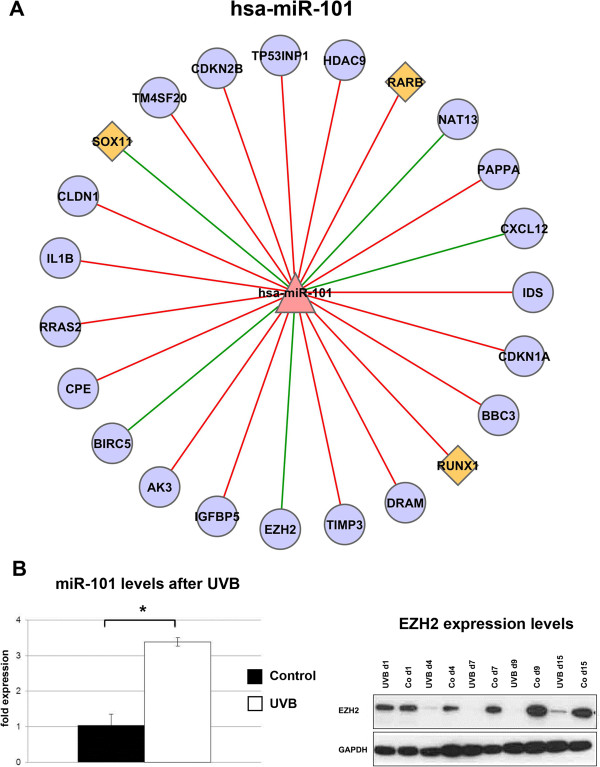
Correlation network of miR-101 and its high confidence target genes. (A) We used 10 prediction tools to obtain, based on public data, candidate miRNA-mRNA target interactions and we identified high confidence targets by mRNA and miRNA expression. We calculated Pearson correlation coefficients between miRNAs and their targets. Results of the analysis are presented here for miR-101. The color and shape of nodes are based on different node attributes available for the analyzed dataset. The red triangles, purple circles and orange diamonds in the network are indicating miRNAs, target genes, and transcription factors, respectively. Edges represent correlation between miRNAs and mRNAs, the color of the edges designate the type of interaction. Red is for positive and green is for negative correlation. (B) Protein samples for the indicated time points were collected as described (left panel). Protein levels were determined for Ezh2 by standard Western blot analysis. Experiments were performed in triplicates, shown here is a representative result. miR-101 levels were determined by real-time qPCR as described (right panel). Data represents the mean ± SE for three independent experiments. Co: untreated controls. *p < 0.01; **p < 0.001.